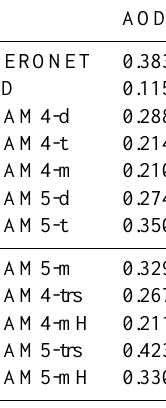
Table 6a. The mean and standard deviation for annually averaged Table 6b. The standard deviation in the model over the standard de- AERONET (Holben et al., 1998, 2001) retrievals and the annually viation in AERONET. Values less than 1 indicate that the model is averaged means for CAM4 with untuned (default) dust (CAM4- not capturing the dynamic range from the observations, while values d), with tuned dust (CAM4-t) and with mineralogy (CAM4-m), for greater than 1 indicate the model is simulating a larger range than CAM5 with untuned dust (CAM5-d), with tuned dust (CAM5-t) observed. This metric is used to test whether the simulations with and with mineralogy (CAM5-m) for aerosol optical depth (AOD), mineralogy are better capturing the range in the observations, with absorbing AOD and single scattering albedo (SSA) at 533nm at italic font denoting an increase in ability and bold font denoting AERONET sites where AOD dust >0.5 · AOD total . The lower por- agreement with the range in AERONET. tion of the table lists the means for the sensitivity studies for CAM4 and CAM5 with tuned dust and release (default) size distribution (CAM4-trs, CAM5-trs) and for CAM4 and CAM5 mineralogy sim- ulations with the source of hematite coming solely from the soil clay fraction (CAM4-mH, CAM5-mH). AOD AAOD SSA AERONET 0.383 0.046 0.923 SD 0.115